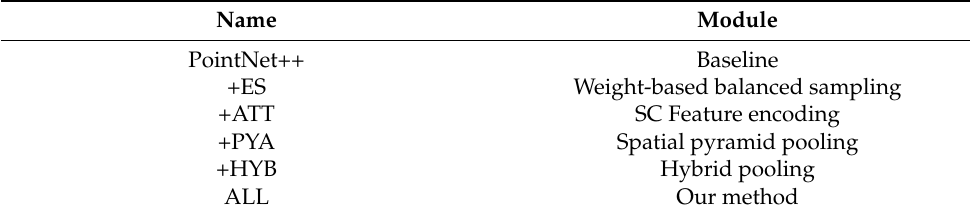
Table 3. Module details.